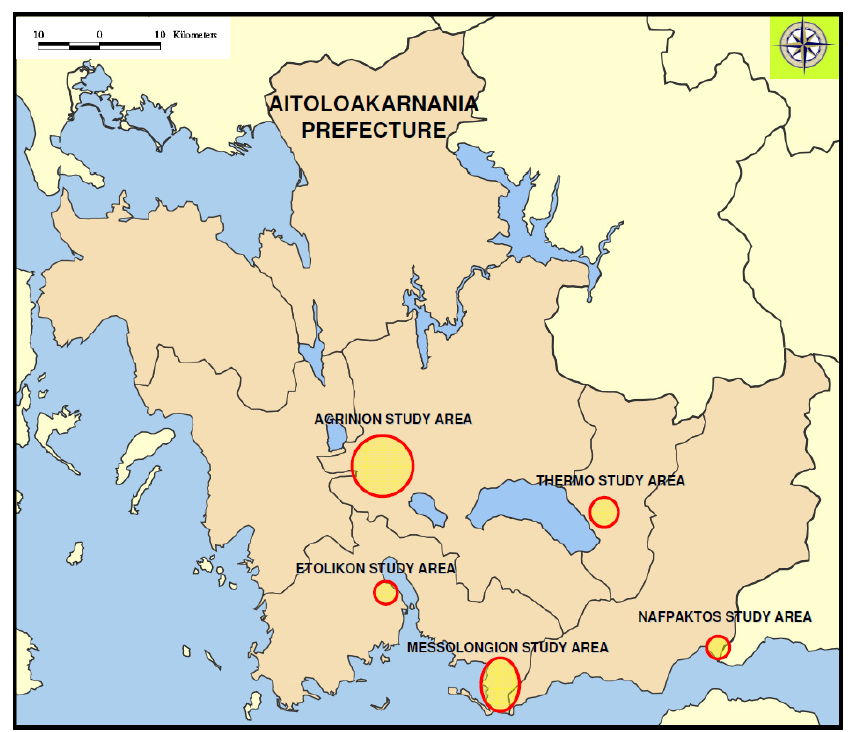
Figure 1. Study area of Aitoloakarnanias